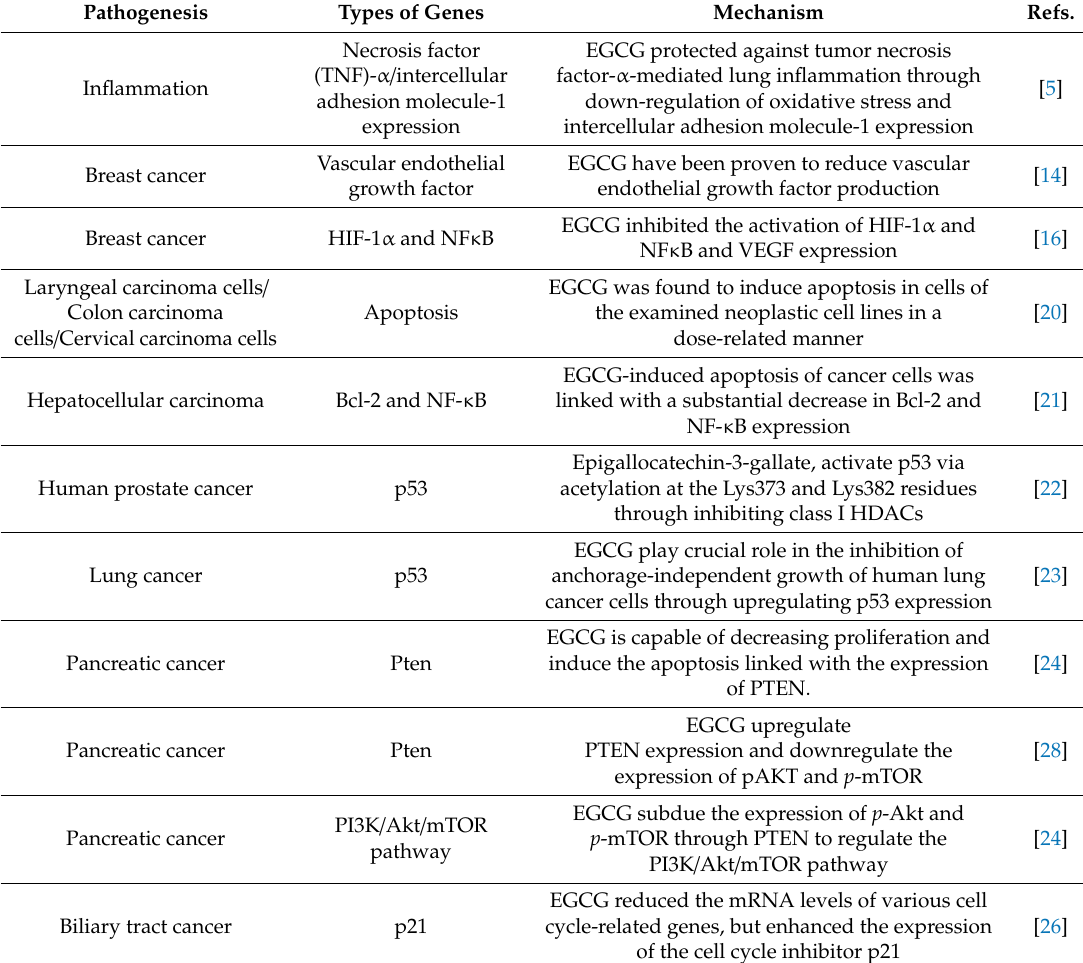
Table 1. Mechanism of action of EGCG in management of cancer through modulating cell signaling